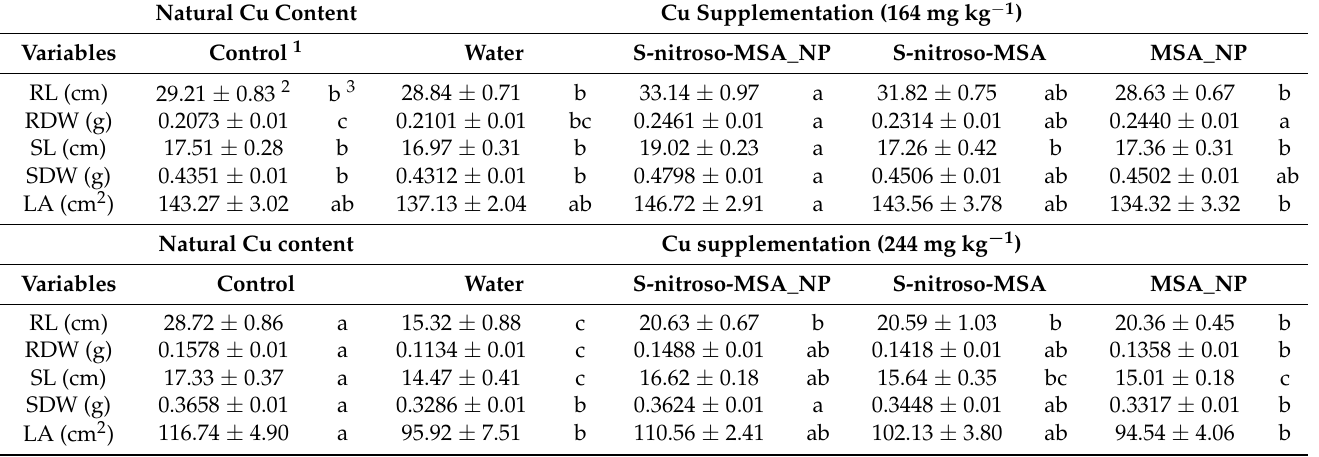
Table 1. Root length (RL), root dry weight (RDW), shoot length (SL), shoot dry weight (SDW), and leaf area (LA) of the soybean plants grown in soil with a natural copper (Cu) content and in soil supplemented with Cu.